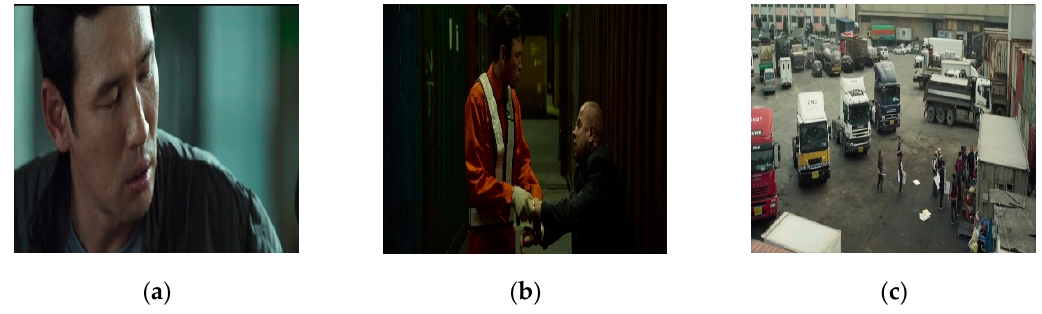
Figure 1. Types of shots in the movie Veteran : ( a ) Close-up shot; ( b ) Medium shot; ( c ) Long shot.